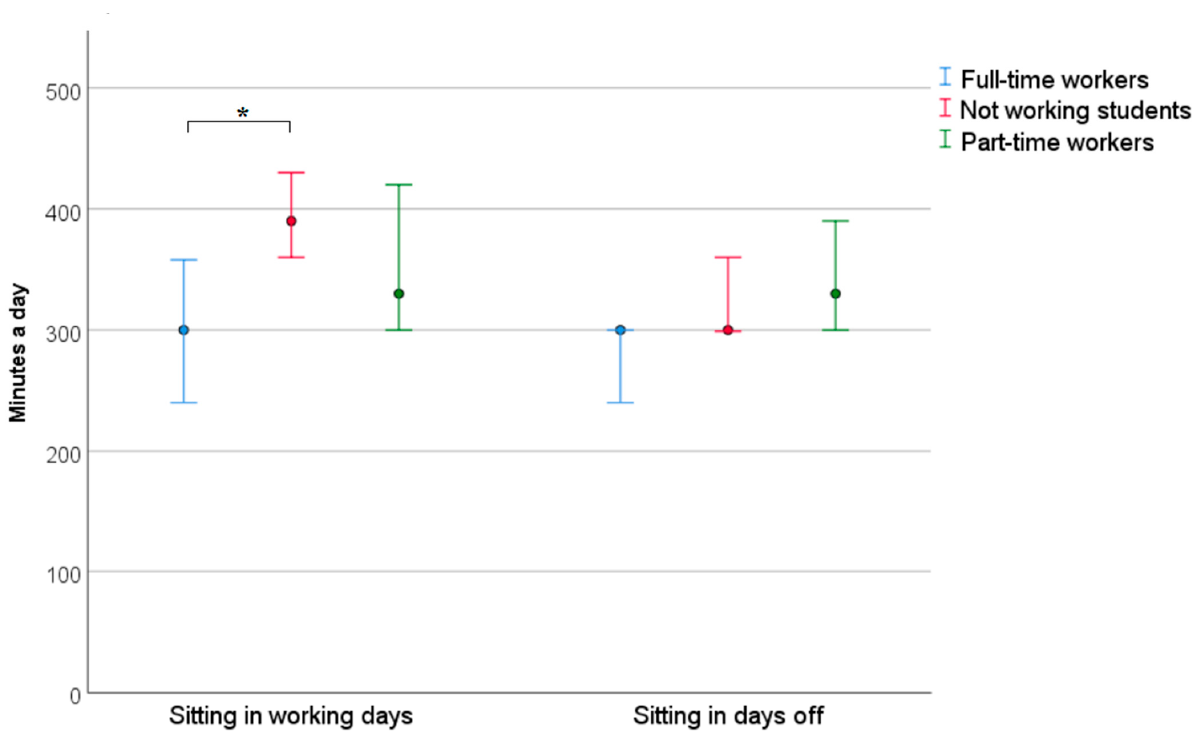
Figure 2. The median and Q1–Q3 of sitting time of students in different groups according to engage- ment in work. * p < 0.05 indicates a significant difference.